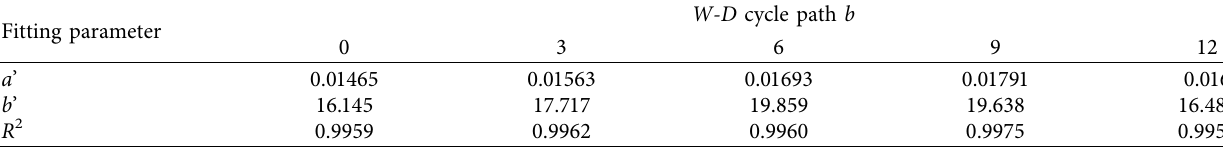
c d and d of W - D cycle path b .